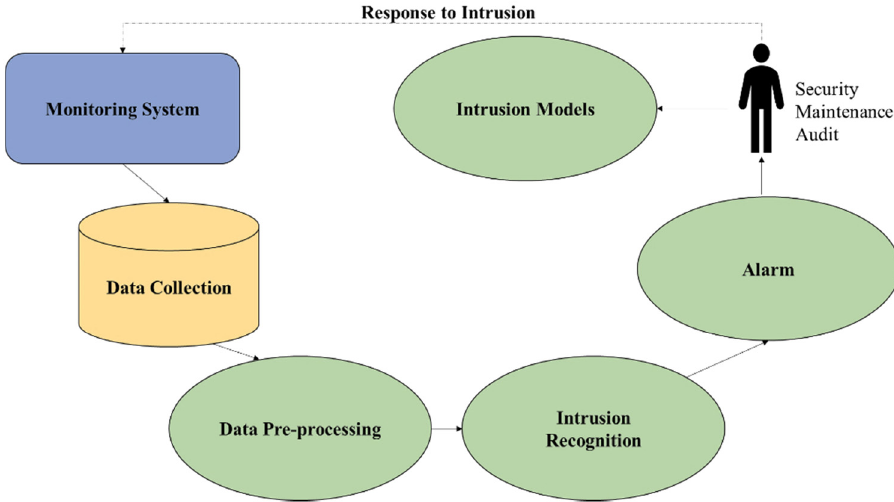
Figure 1: Architecture of a basic intrusion detection